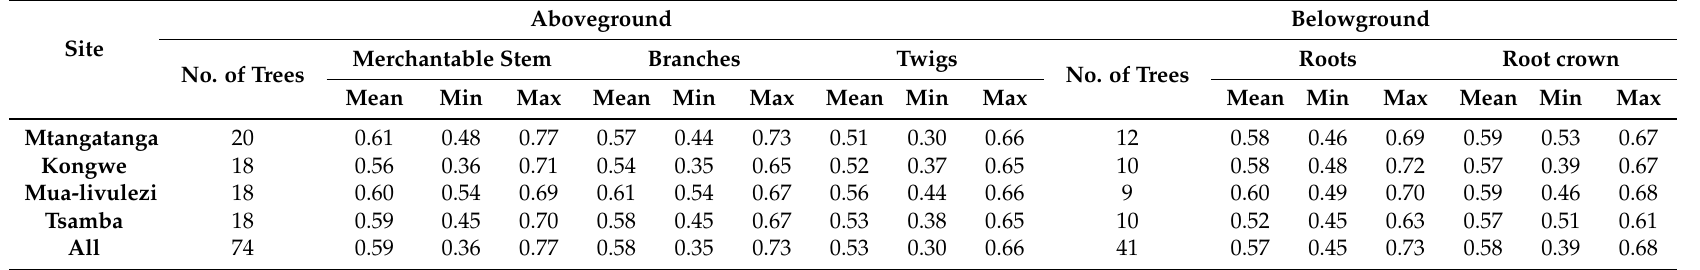
Table A2. DF-ratio for merchantable stem, branches, twigs, roots, and root crown in the four study sites.